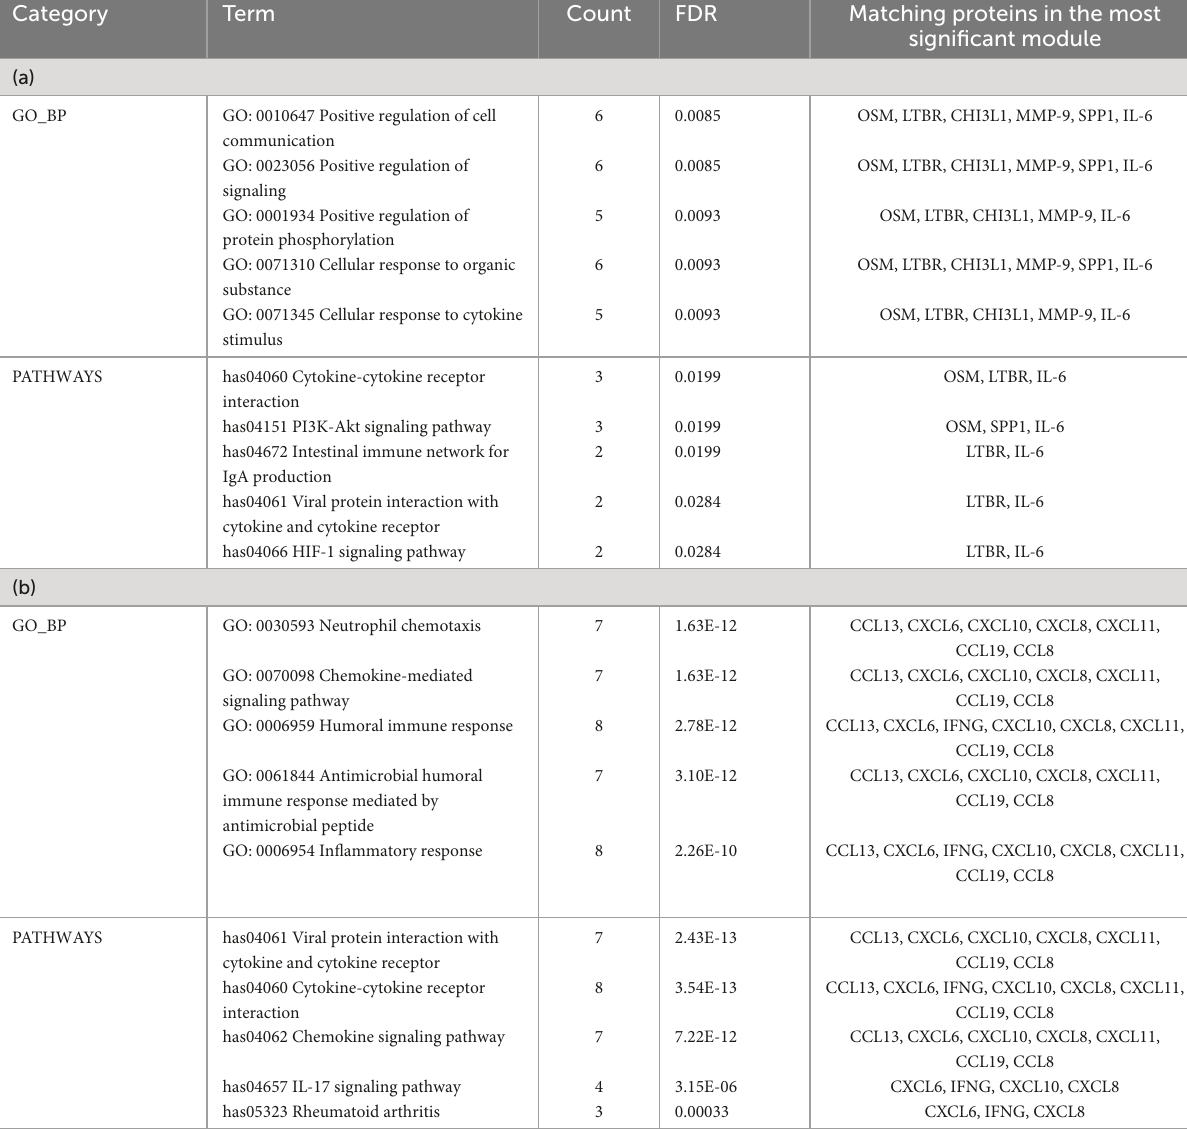
TABLE 4 GO_BP and KEGG pathways enriched in the most significant module in the RB group (only top five listed). Category Term Count FDR Matching proteins in the most